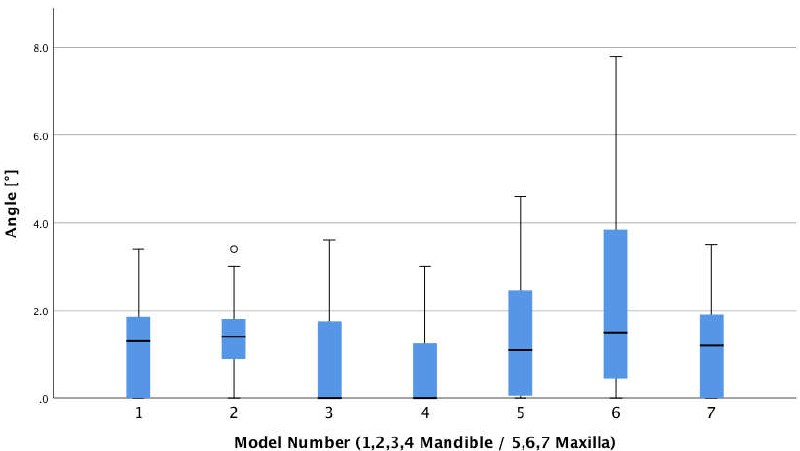
Figure 3. Angle deviation between the planned and prepared access cavities on the three maxillary and four mandibular models. Table 1. Deviation between planned and prepared access cavities regarding angle deviation and mesio-distal and bucco-oral deviation at the tip and base of the bur.